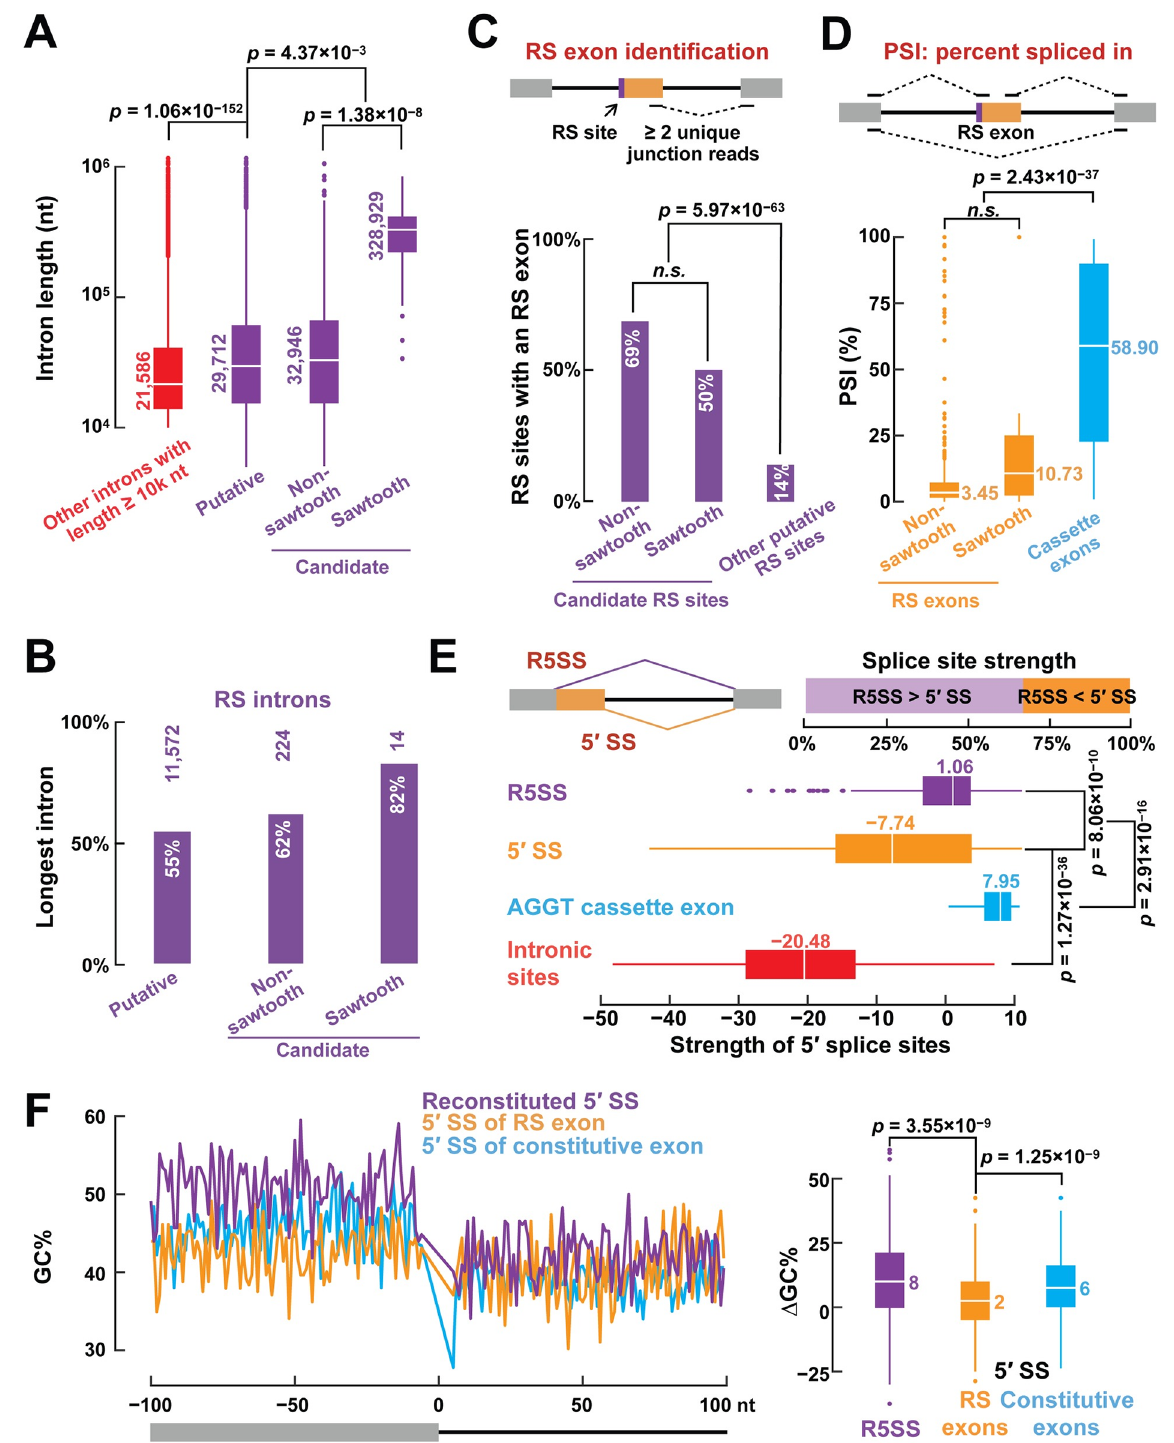
Fig 3. Sequence features of recursive splicing in humans. (A) RS sites tend to reside in long introns. Introns with putative, candidate or sawtooth RS sites have increasing lengths (Wilcoxon rank-sum tests). (B) Most introns with putative, candidate or sawtooth RS sites correspond to the longest introns of their genes. (C) We predict that more than 50% of candidate RS sites are followed by an RS exon supported by at least two unique 4sUDRB-seq junction reads, a significantly higher percentage than the putative RS sites that are not candidate RS sites (Fisher’s exact test). (D) The Percent-Spliced-In (PSI) values of RS exons are significantly lower than those of cassette exons according to steady-state